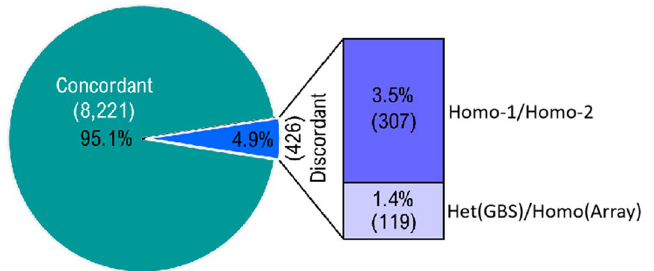
Figure 2. Concordance of genotype calls made using both marker platforms (GBS and 90 K SNP Array). GBS- derived SNP genotypes were compared to the genotypes called at loci in common with the 90 K SNP Array for the same 71 wheat samples.